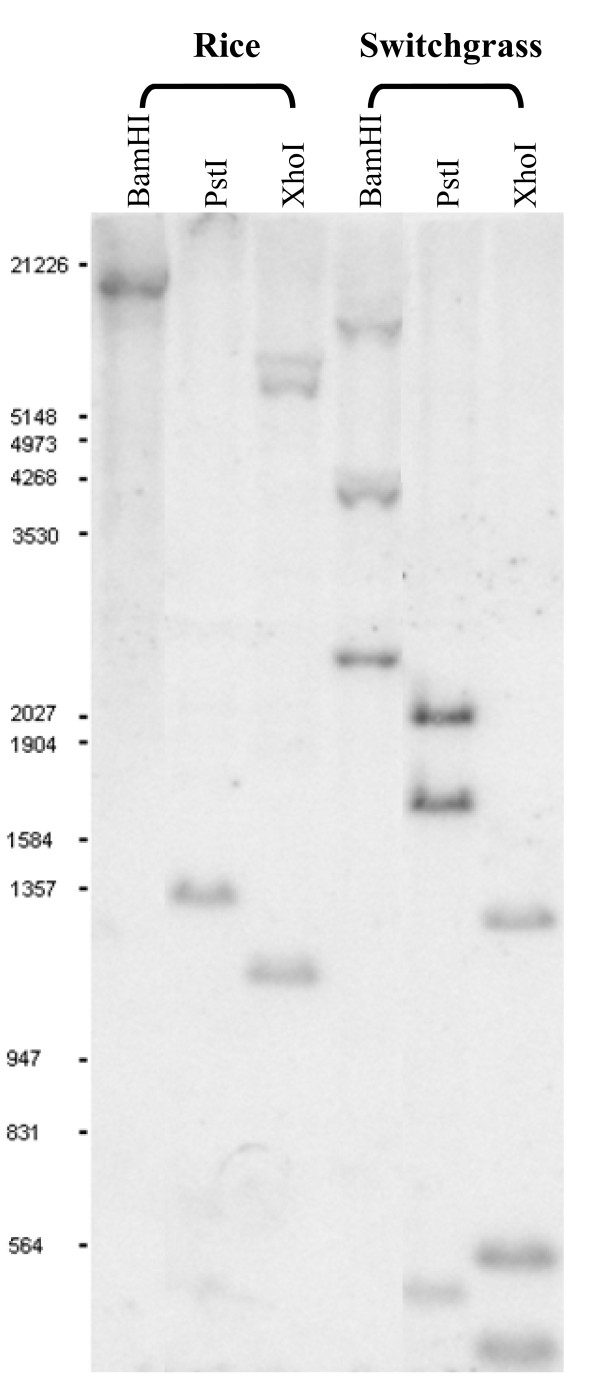
Southern analysis of switchgrass genome region containing OSBRI1 homolog. The genomic DNA of rice and switchgrass plants was digested with BamHI, PstI and XhoI respectively and the OsBRI1 gene was used as the probe for hybridization with the digested DNA. Predicted and observed RFLP patterns revealed by OSBRI1 in rice and switchgrass were summarized in Table 4.